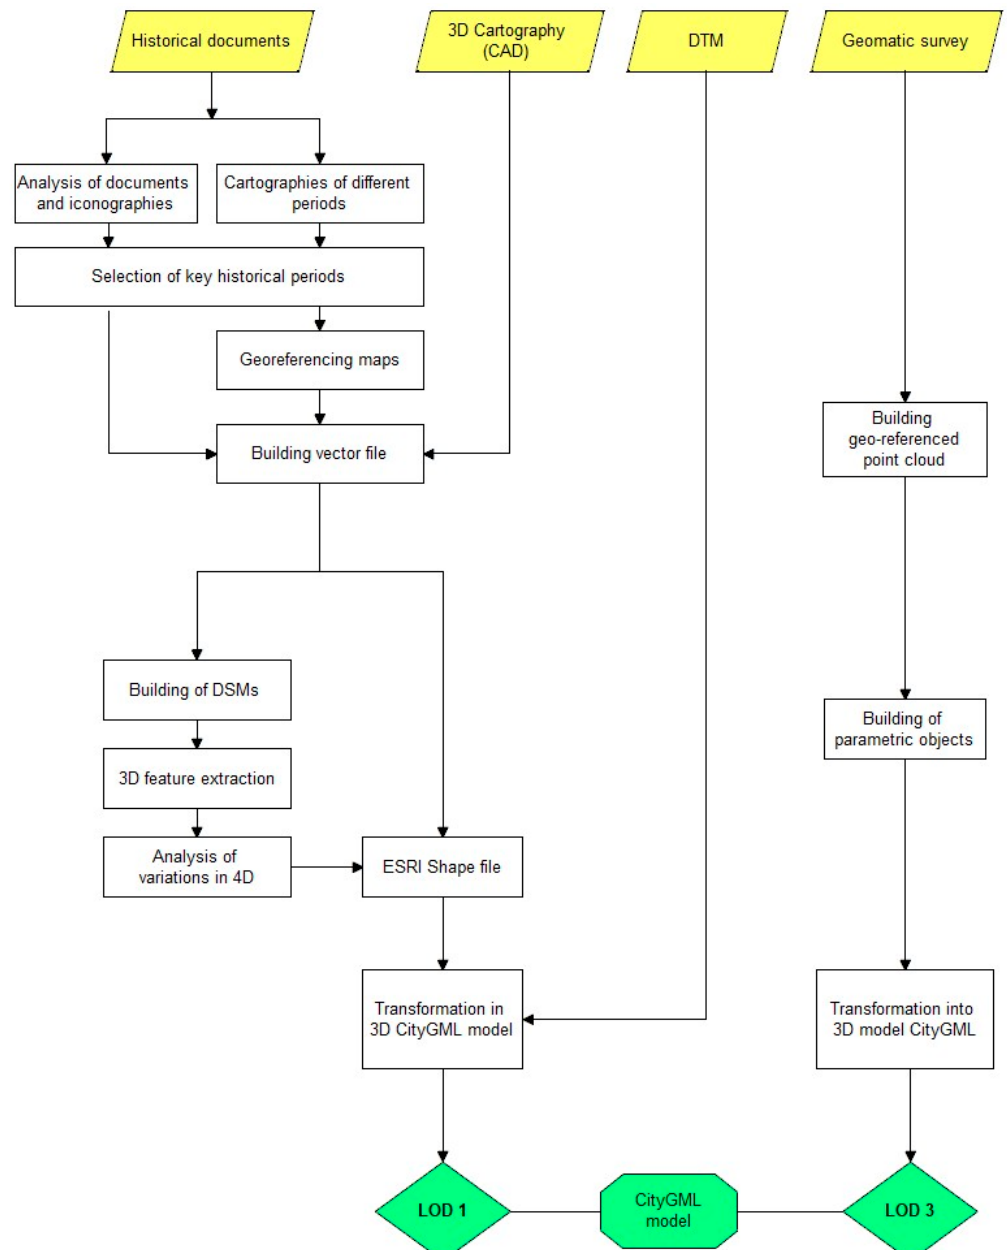
Figure 1. Pipeline of the developed method.